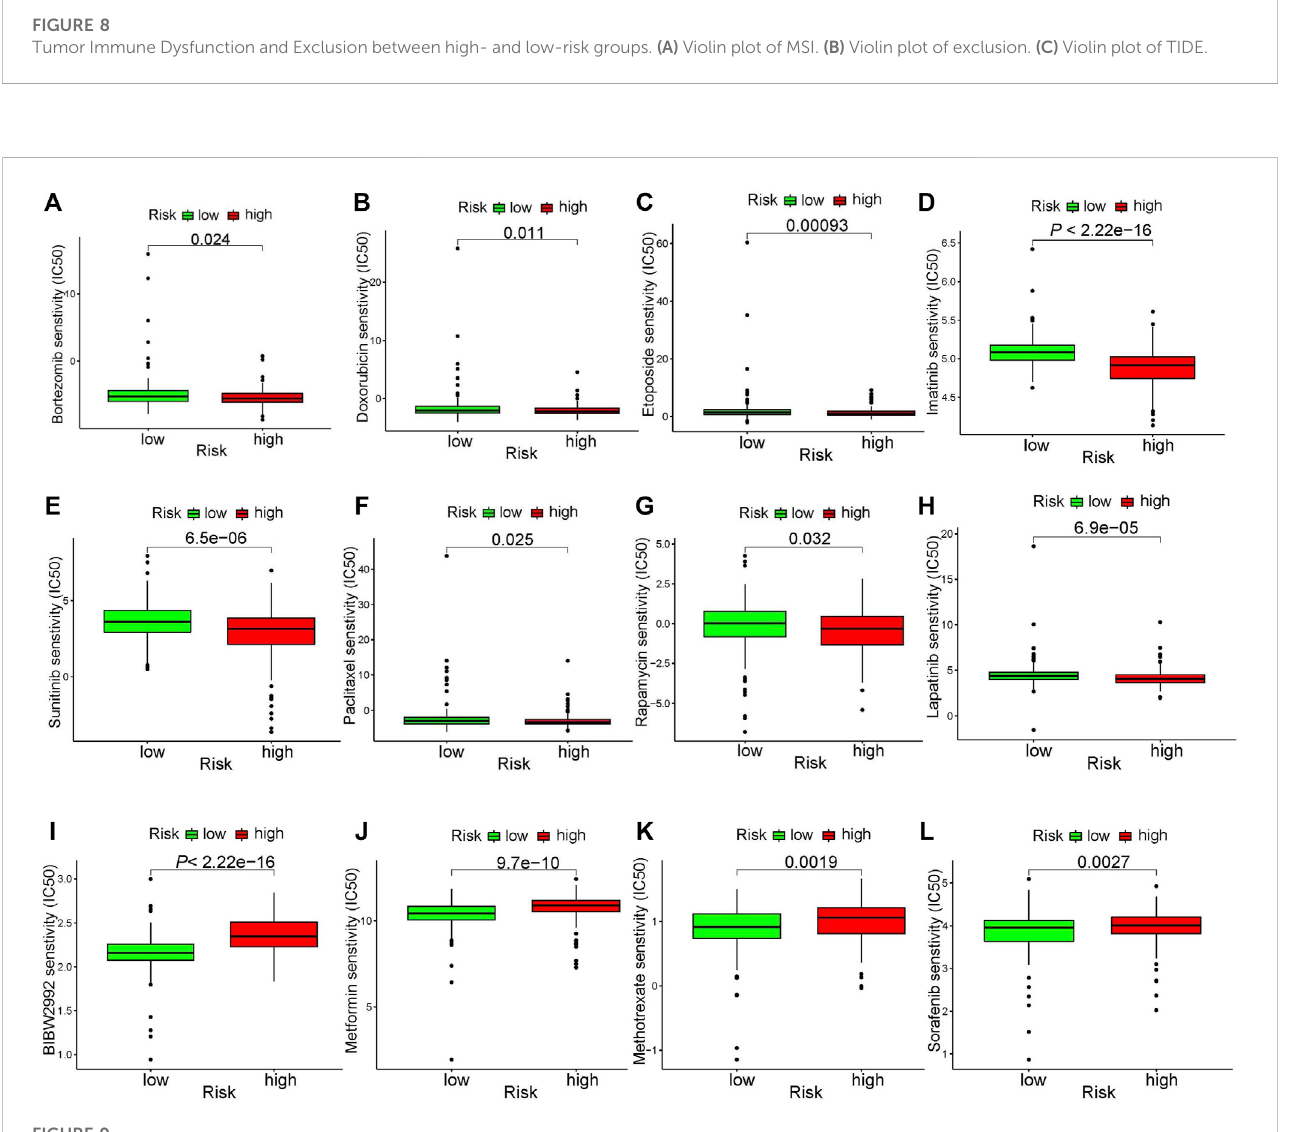
FIGURE 9 Chemotherapeutic drug sensitivity analysis. (A – H) drugs more sensitive in high-risk group. (I – L) drugs more sensitive in low-risk group.